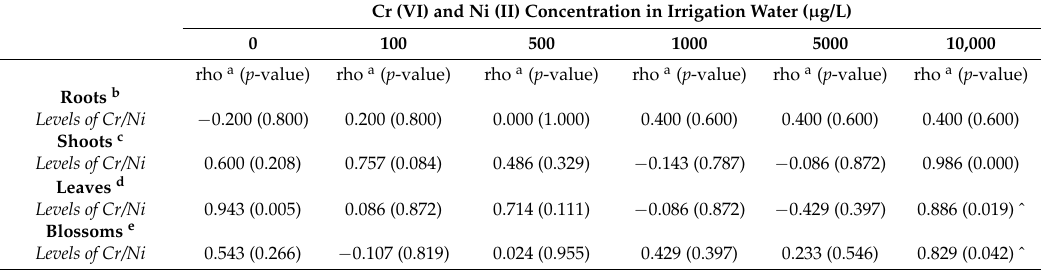
Table 2. Correlation Cr and Ni in shoots, leaves, blossoms, and roots by concentration in irrigation line. Cr (VI) and Ni (II) Concentration in Irrigation Water ( µ